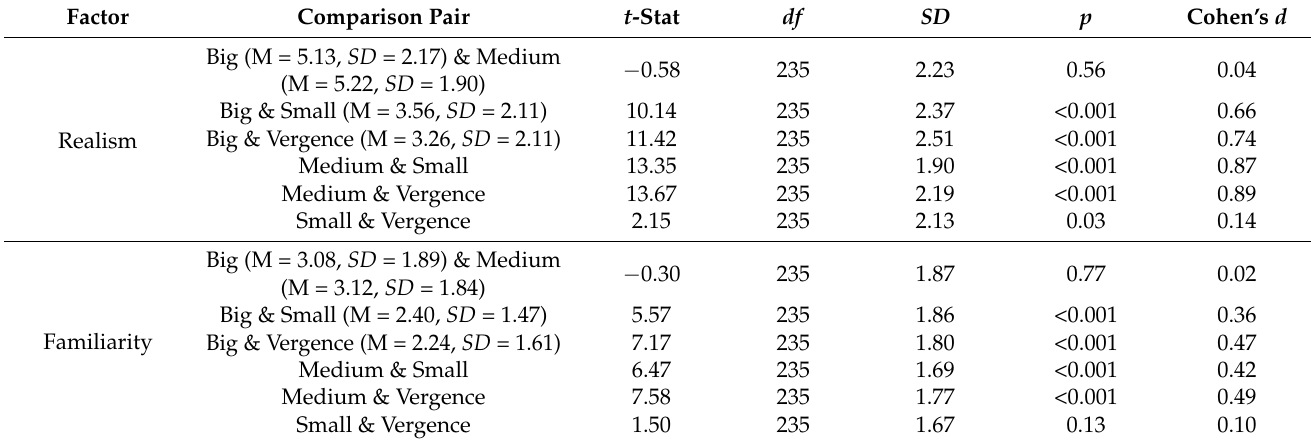
Table 3. Post-hoc comparisons for realism and familiarity ratings in Experiment